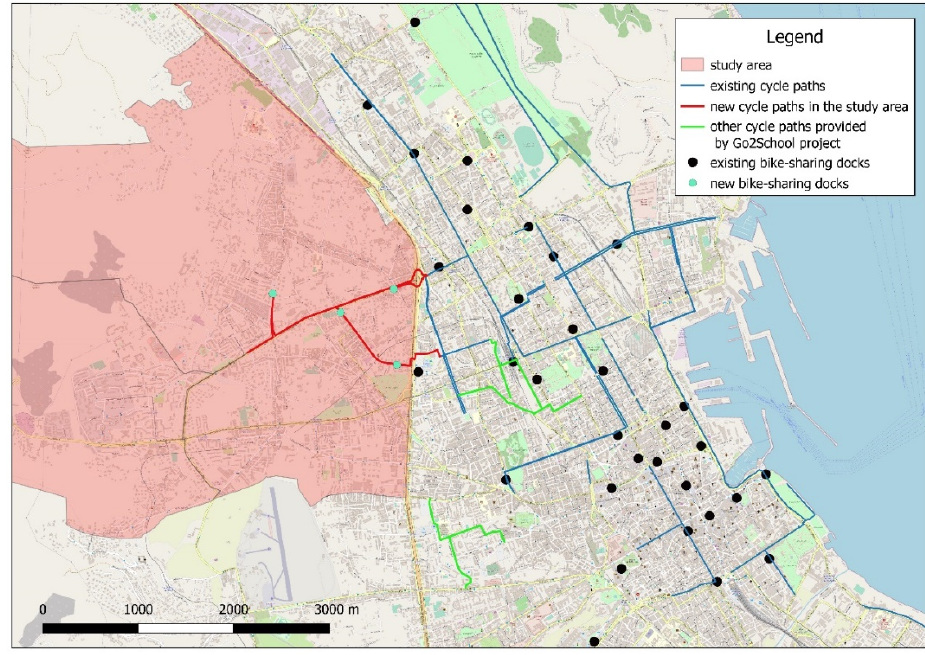
Figure 5. The new cycle paths and the new bike-sharing docks in Palermo.